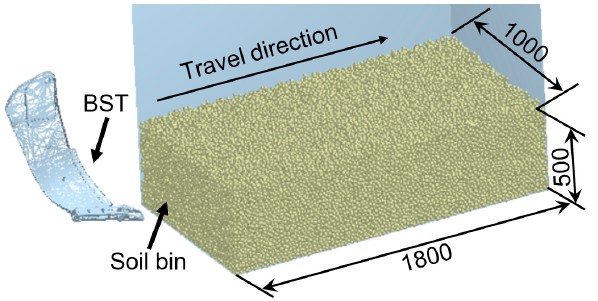
Figure 4. Discrete element models for the bending subsoiling tool (BST). Table 1. Major parameters for the discrete element model.